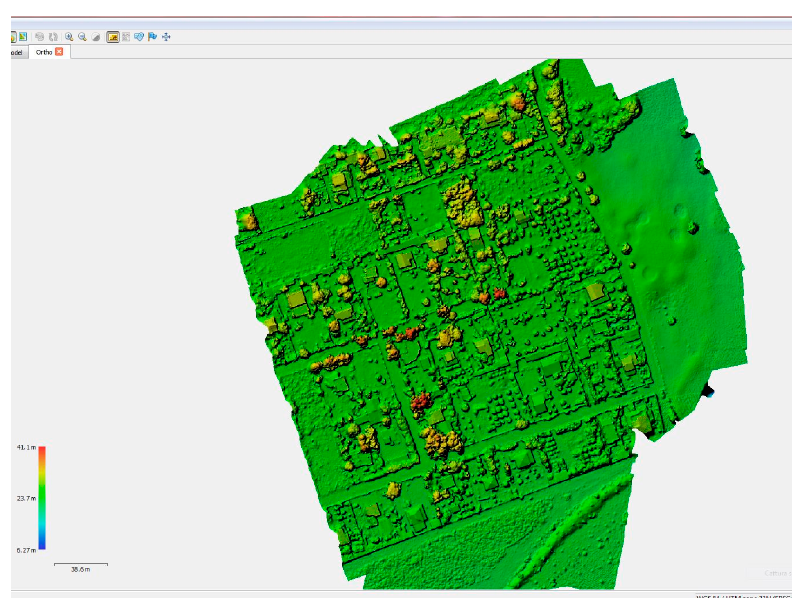
ISPRS Int. J. Geo-Inf. 2017 , 6 , 393